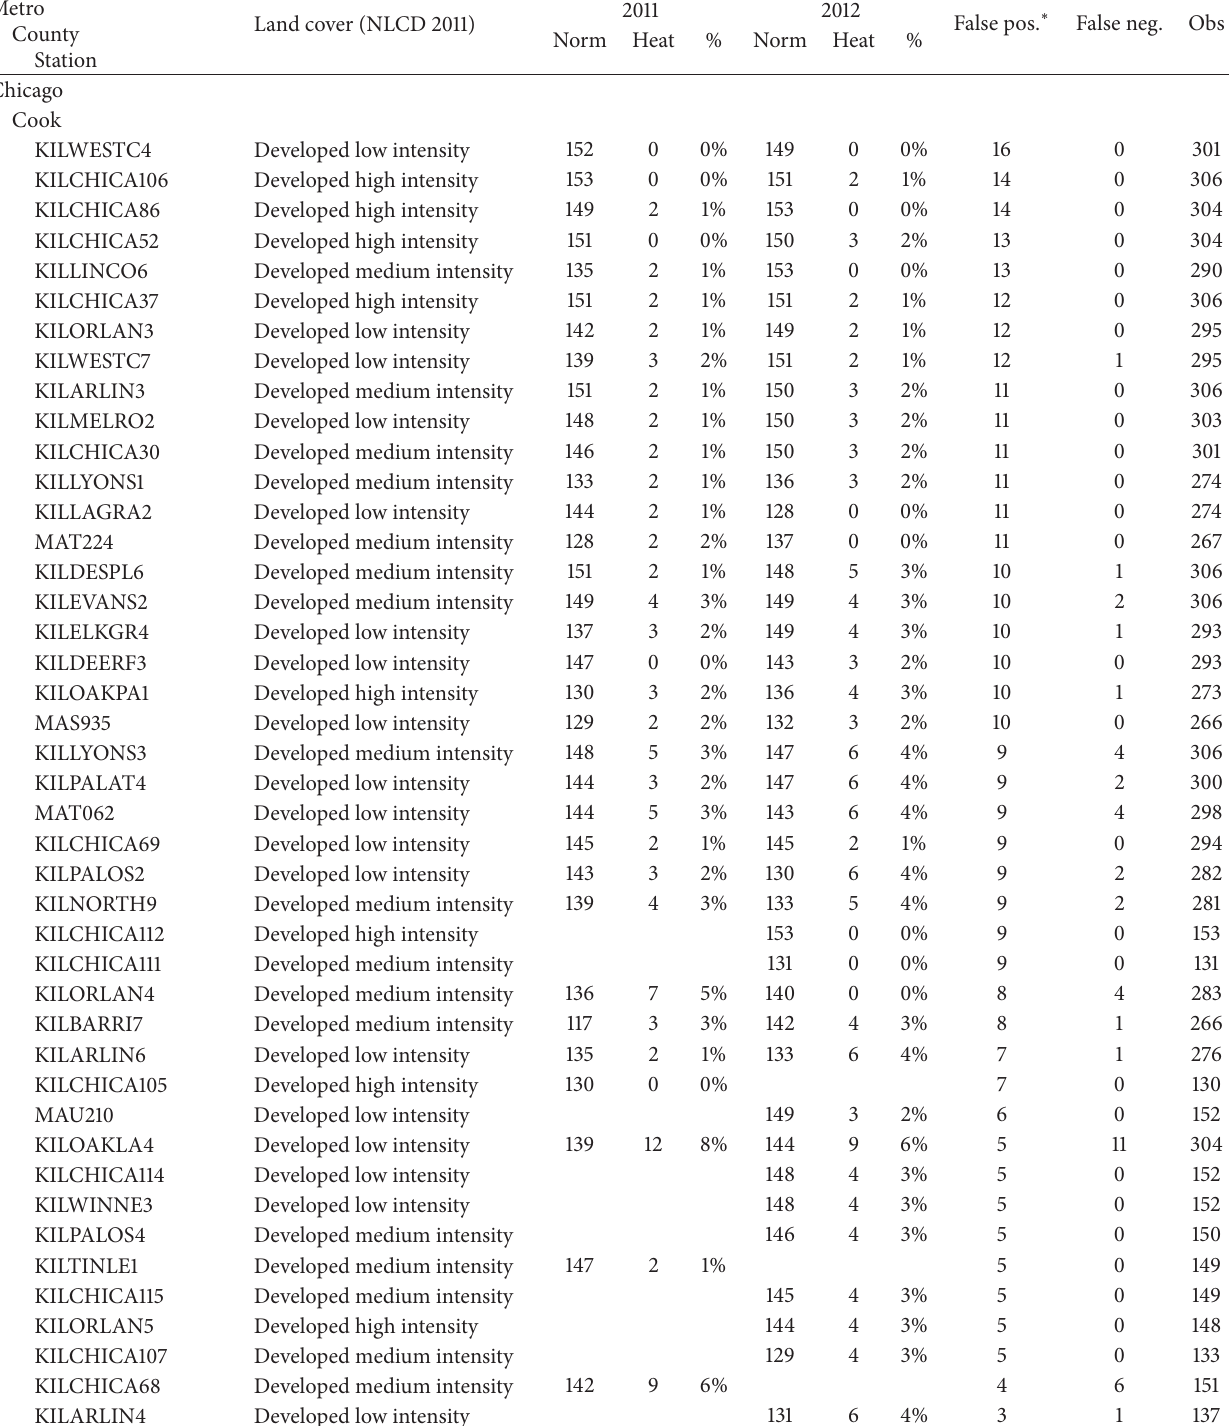
Table 2: Chicago weather station details on the number of normal (“Norm”) and Advisory (“Heat”) days during the summer of 2011 and 2012. The total number of false positives (no station hazard with NWS Advisory) and false negatives (station hazard with no NWS Advisory) is also provided to give an idea of the agreement between the station and the NWS Advisories for that